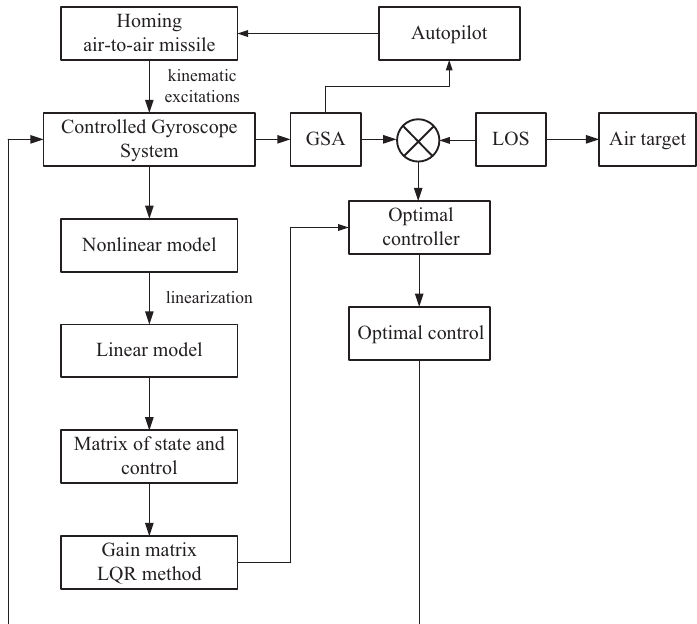
Figure 1. Block diagram of a gyroscope system control system operation within the homing